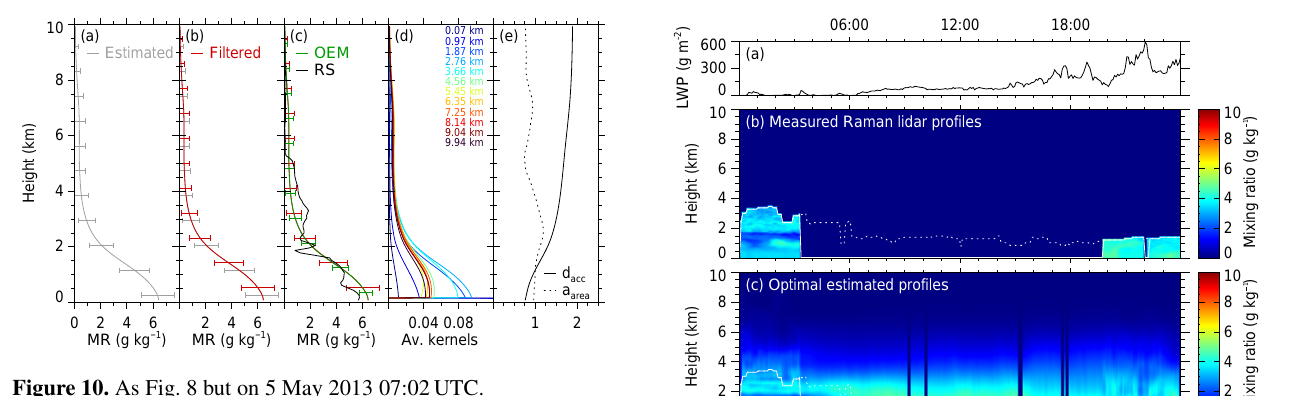
Figure 10. As Fig. 8 but on 5 May 2013 07:02UTC.